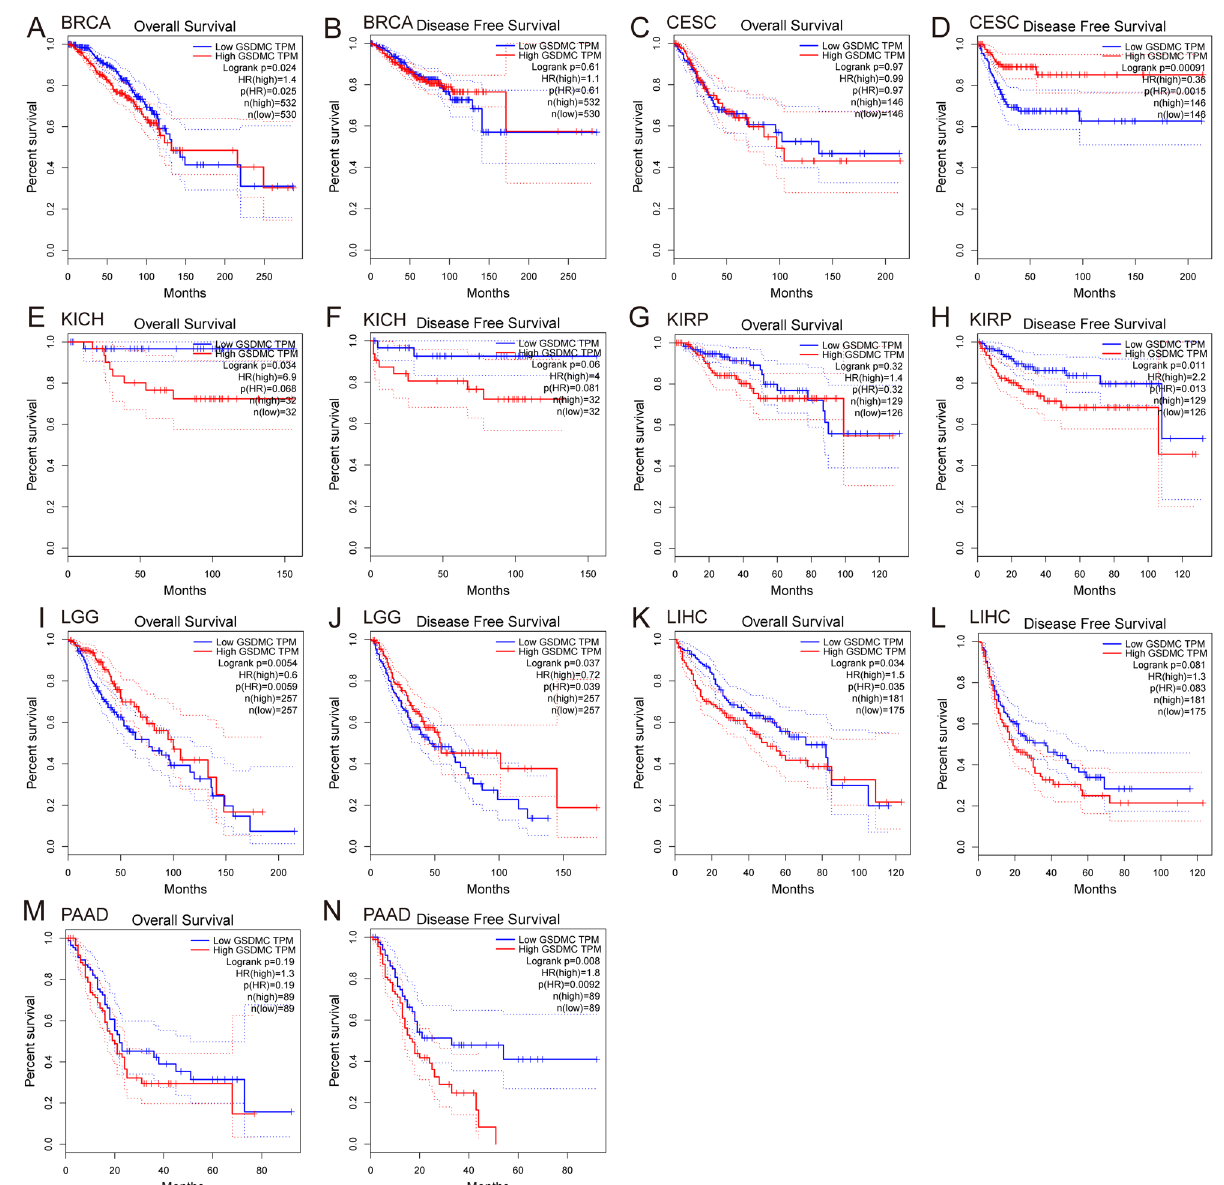
Figure 5. Prognostic analysis of GSDMC mRNA expression levels in various human cancers determined by GEPIA database ( A–N ). OS overall survival, DFS disease-free